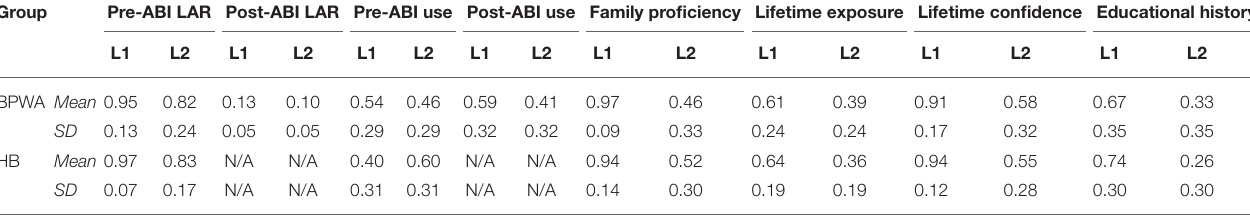
TABLE 1 | Average language use questionnaire metrics for bilingual people with aphasia and healthy bilinguals.